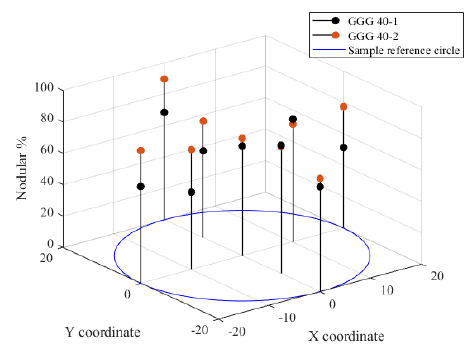
Figure 10. Graphite percentage in